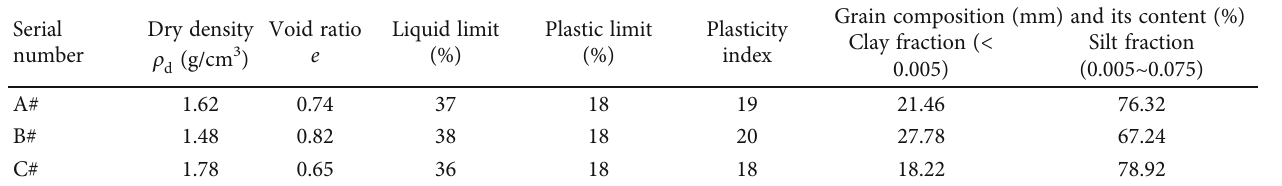
Table 1: Physical properties of remolded unsaturated